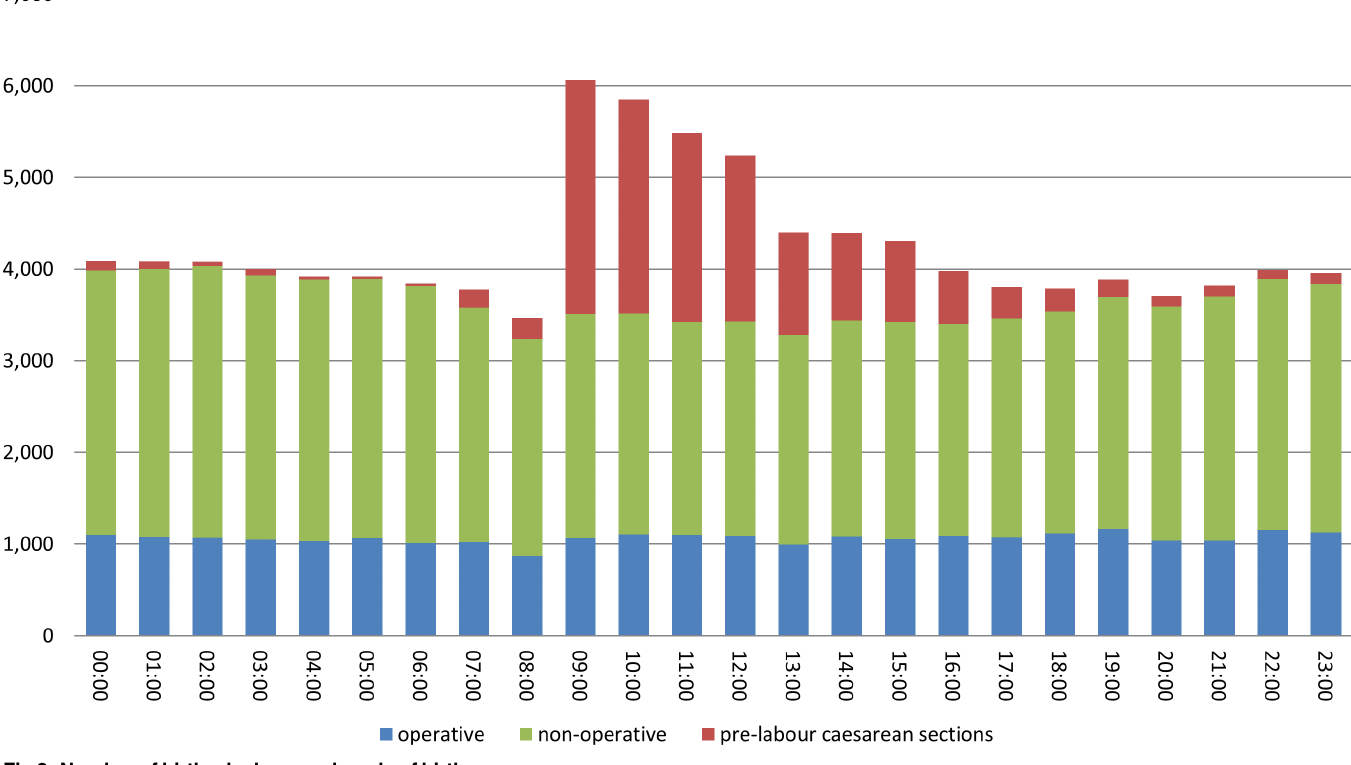
Fig 2. Number of births, by hour and mode of